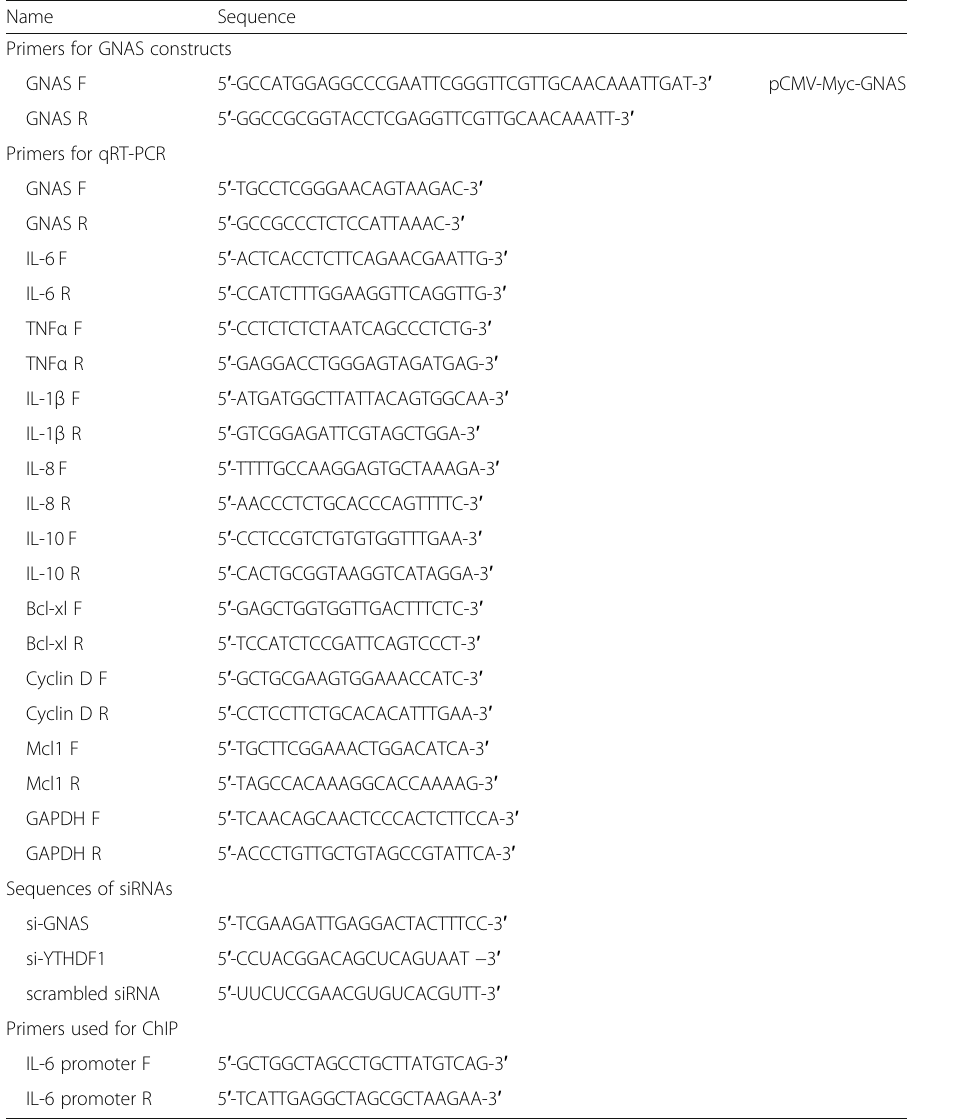
Table 1 Primers used in this study (F: forward primer; R: reverse